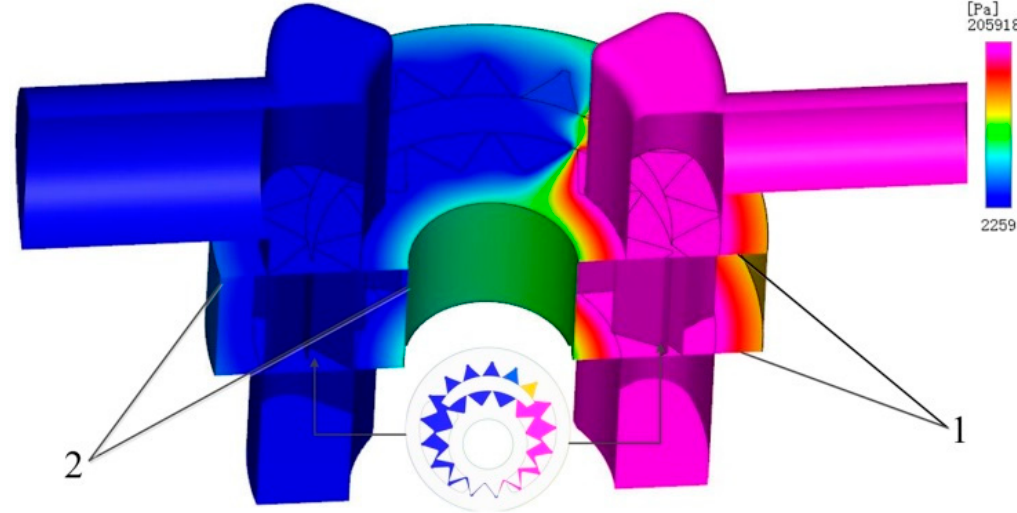
Figure 12. Pressure cloud diagram of the internal flow channel: 1–axial clearance; 2–radial clearance.